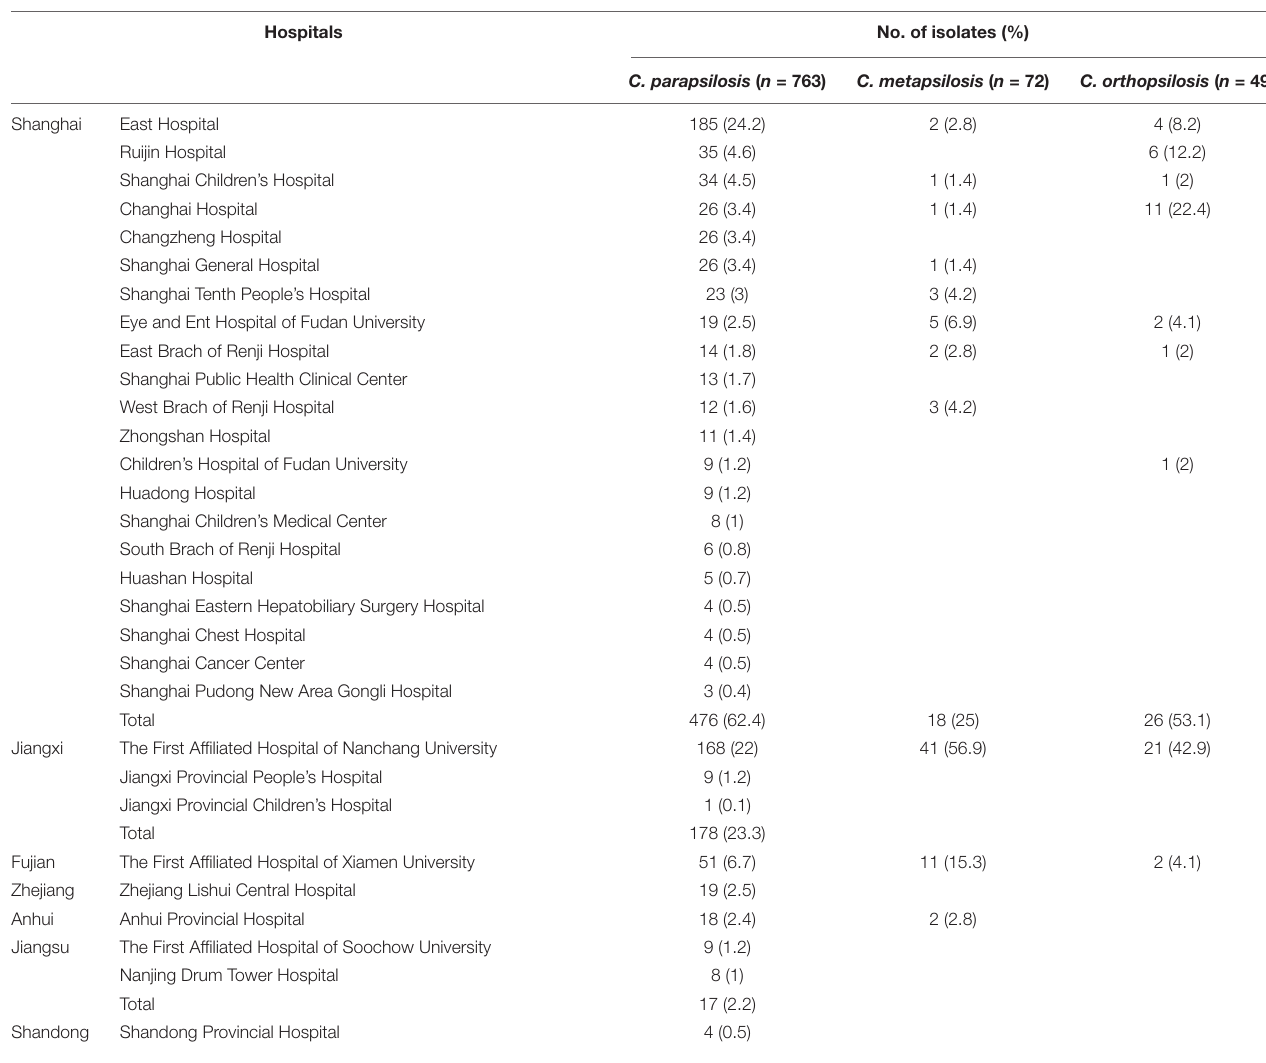
TABLE 1 | Number of C. parapsilosis complex isolates collected from different hospitals.